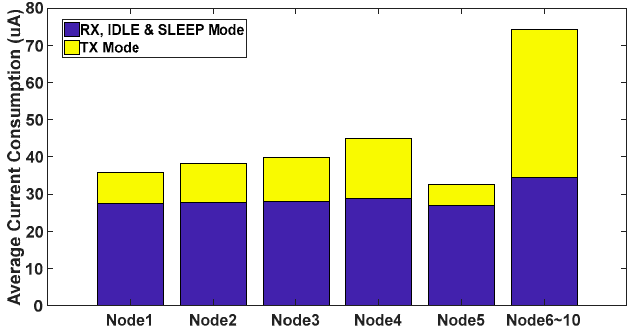
Figure 15. Nodes overall average current consumption.